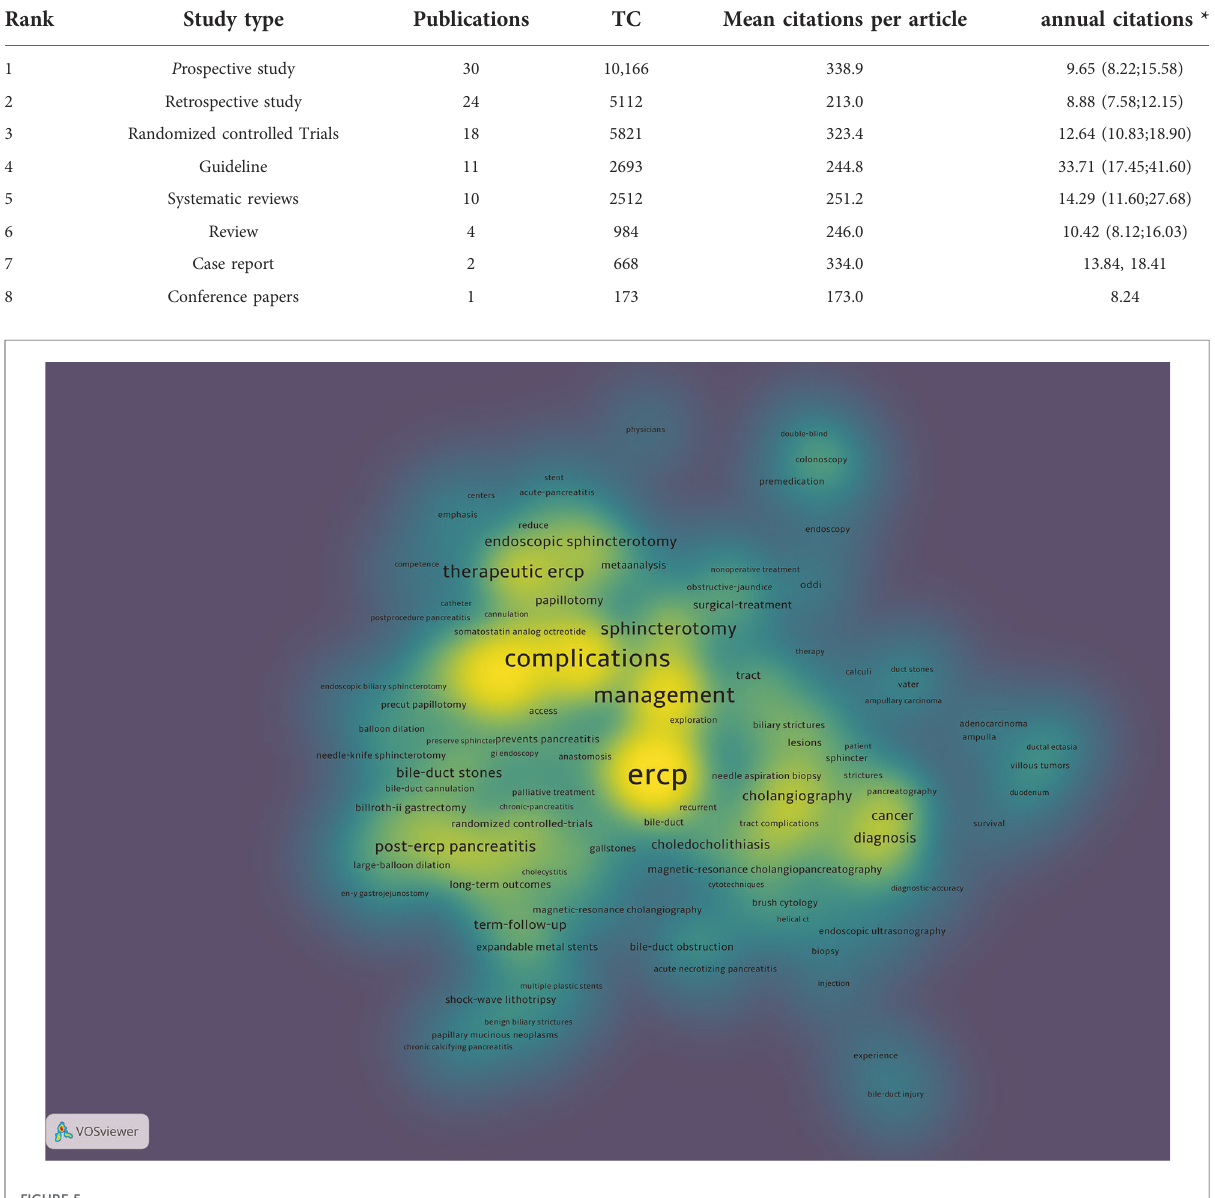
TABLE 5 Types of documents. * Expressed in the median ( fi rst quartile [Q1], third quartile [Q3]). Rank Study type